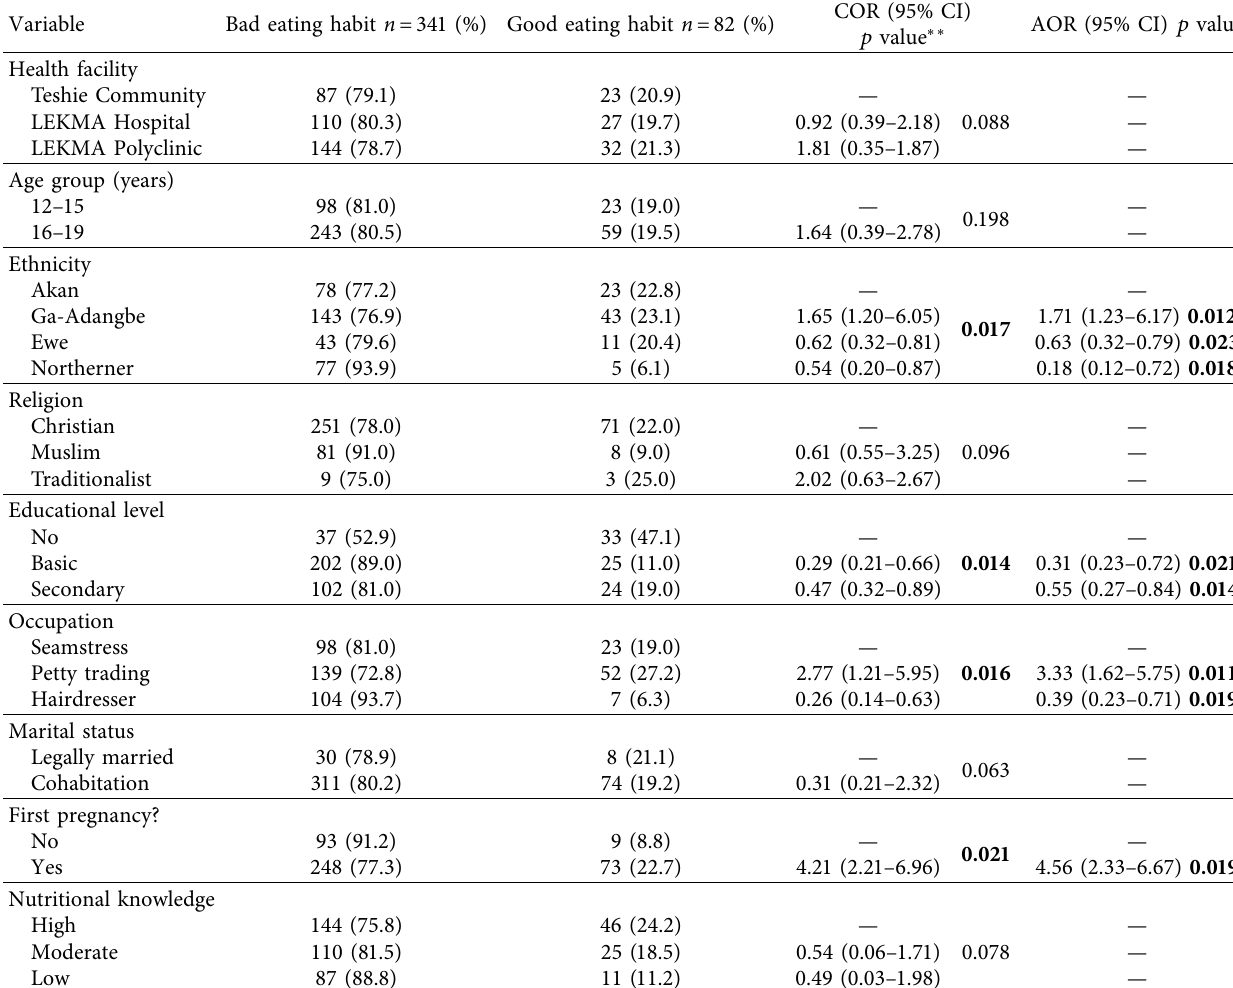
Table 3: Association between respondents eating habits and demographic